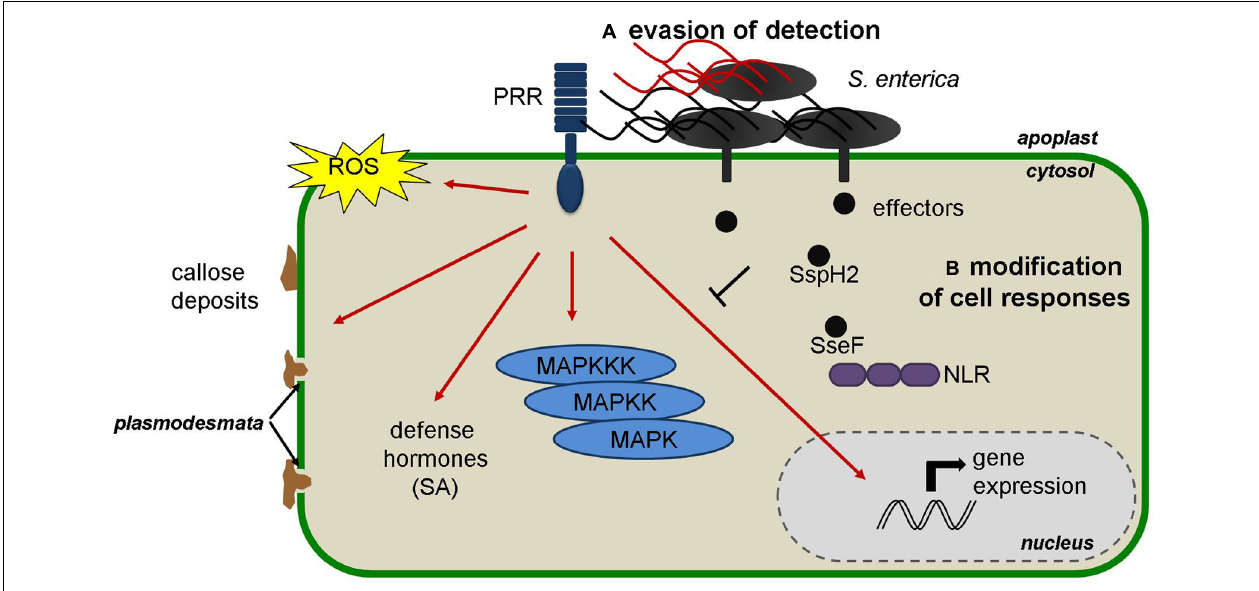
FIGURE 1 | Representation of the defense responses induced upon S. enterica perception in plants and the hypothetical mechanisms that could be used by S. enterica to accomplish plant colonization: (A) evasion of detection by PRRs through modification of PAMPs